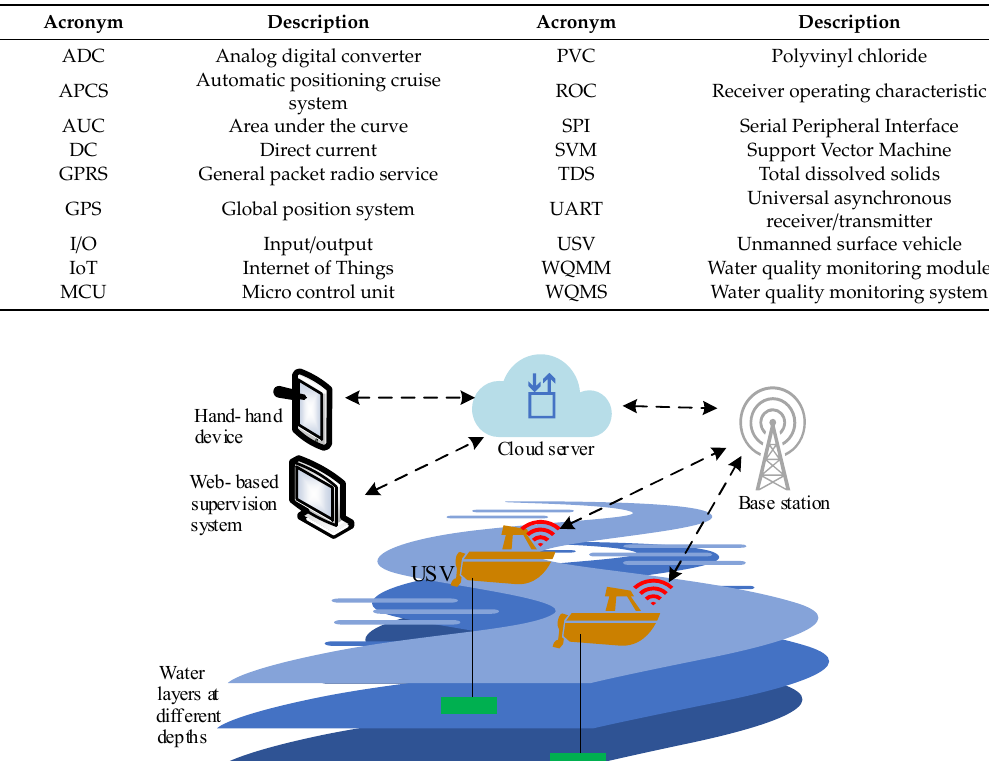
Table 1. Acronyms used in this paper.